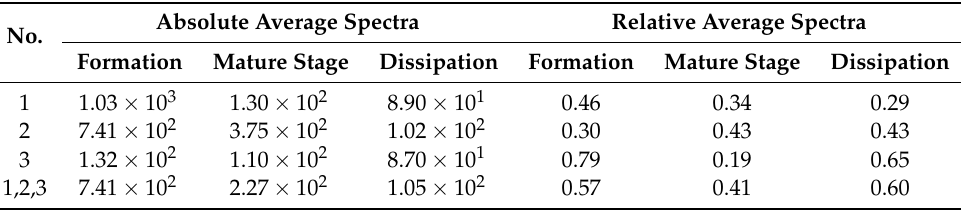
Table 2. Representativity R (cm − 3 ) of the average spectra.